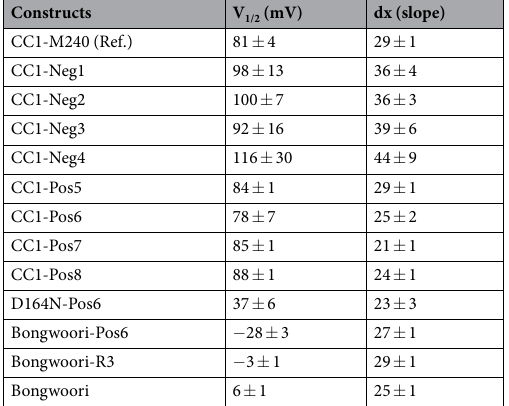
Table 1. The Boltzmann fit results of GEVIs tested in HEK 293 cells. V 1/2 is the membrane potential at half the maximal fluorescence change. Values were shown as mean ± SEM (standard error of the mean). The number